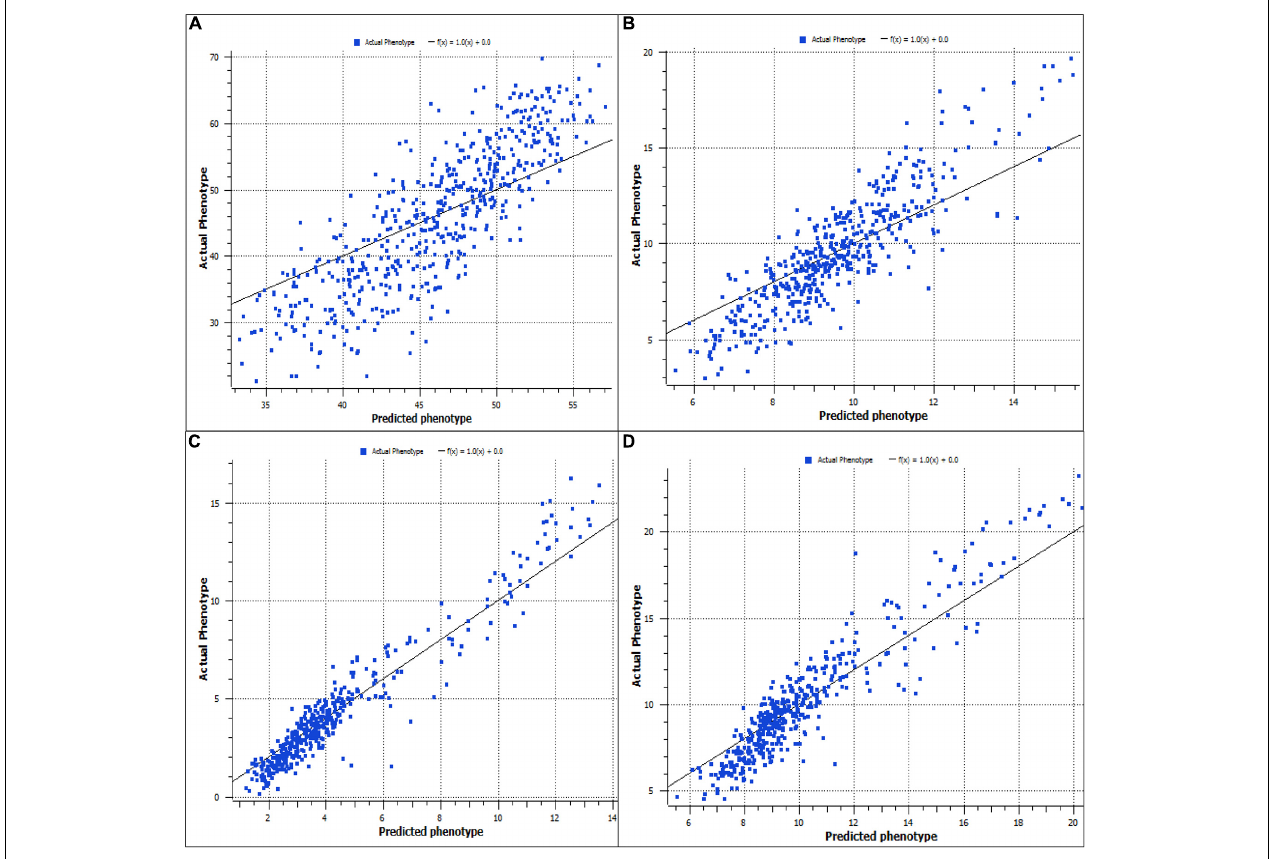
FIGURE 1 | Prediction accuracy for whole weight (A) , soft tissue weight (B) , mantle color a (C) , and mantle color b (D)